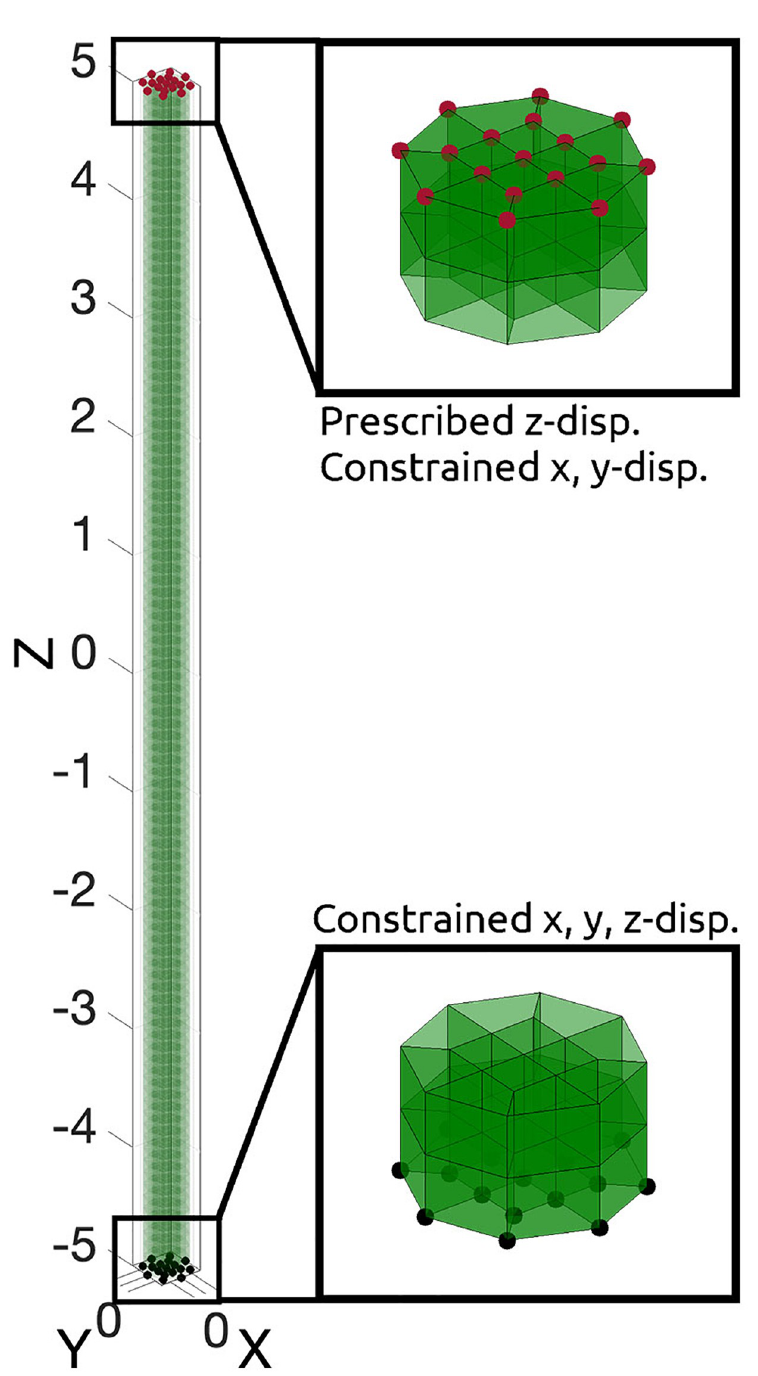
Fig 7. A single fibre. The hexahedral mesh of a single fibre (left) used for iFEA, and two close-ups for the top two and bottom two element layers. The top surface nodes (red) feature a prescribed z-displacement and a zero x, and y displacement constraint. The bottom surface nodes (black) are fully constrained from